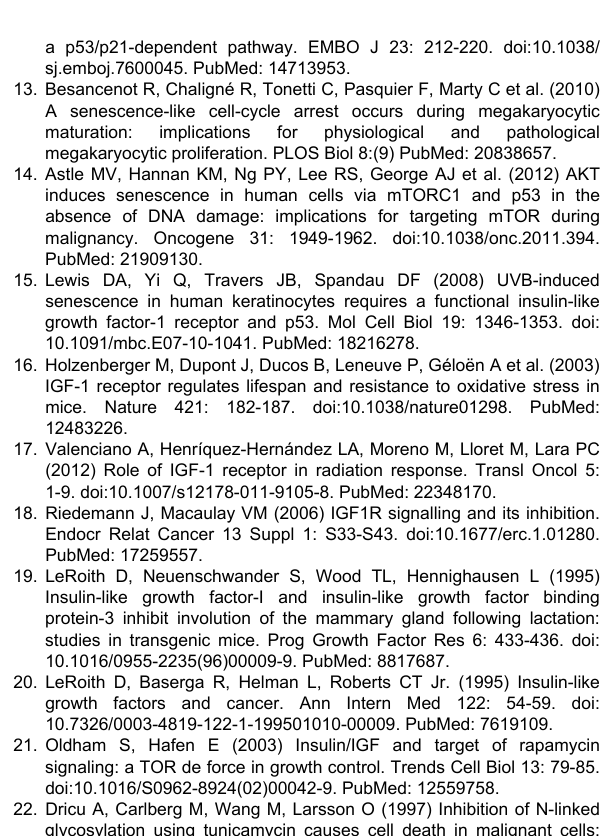
Table S1. Human Cellular Senescence Array. Subconfluent cultures of HPAEC were irradiated (10 Gy) or sham-irradiated. At 72 hours post-irradiation, 1.0 μg of RNA was subjected to reverse transcription in a total volume of 20 ml using High Capacity RNA-cDNA mix kit (Applied Biosystems) and a human cellular senescence array analysis was performed according to manufacturer’s instructions (Qiagen, SABiosciences) (n = 1). Genes with at least 1.5 fold upregulation or downregulation were tabulated.